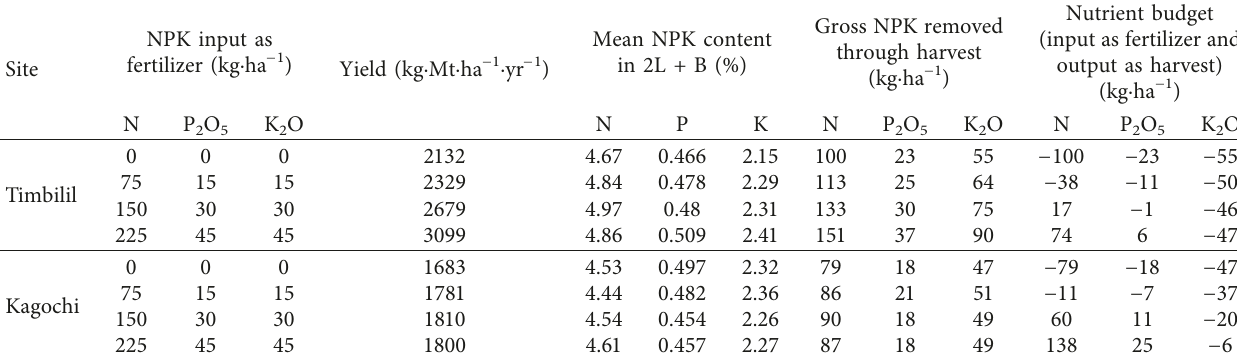
Table 3: Apparent nutrient budget of standard NPK in Timbilil and